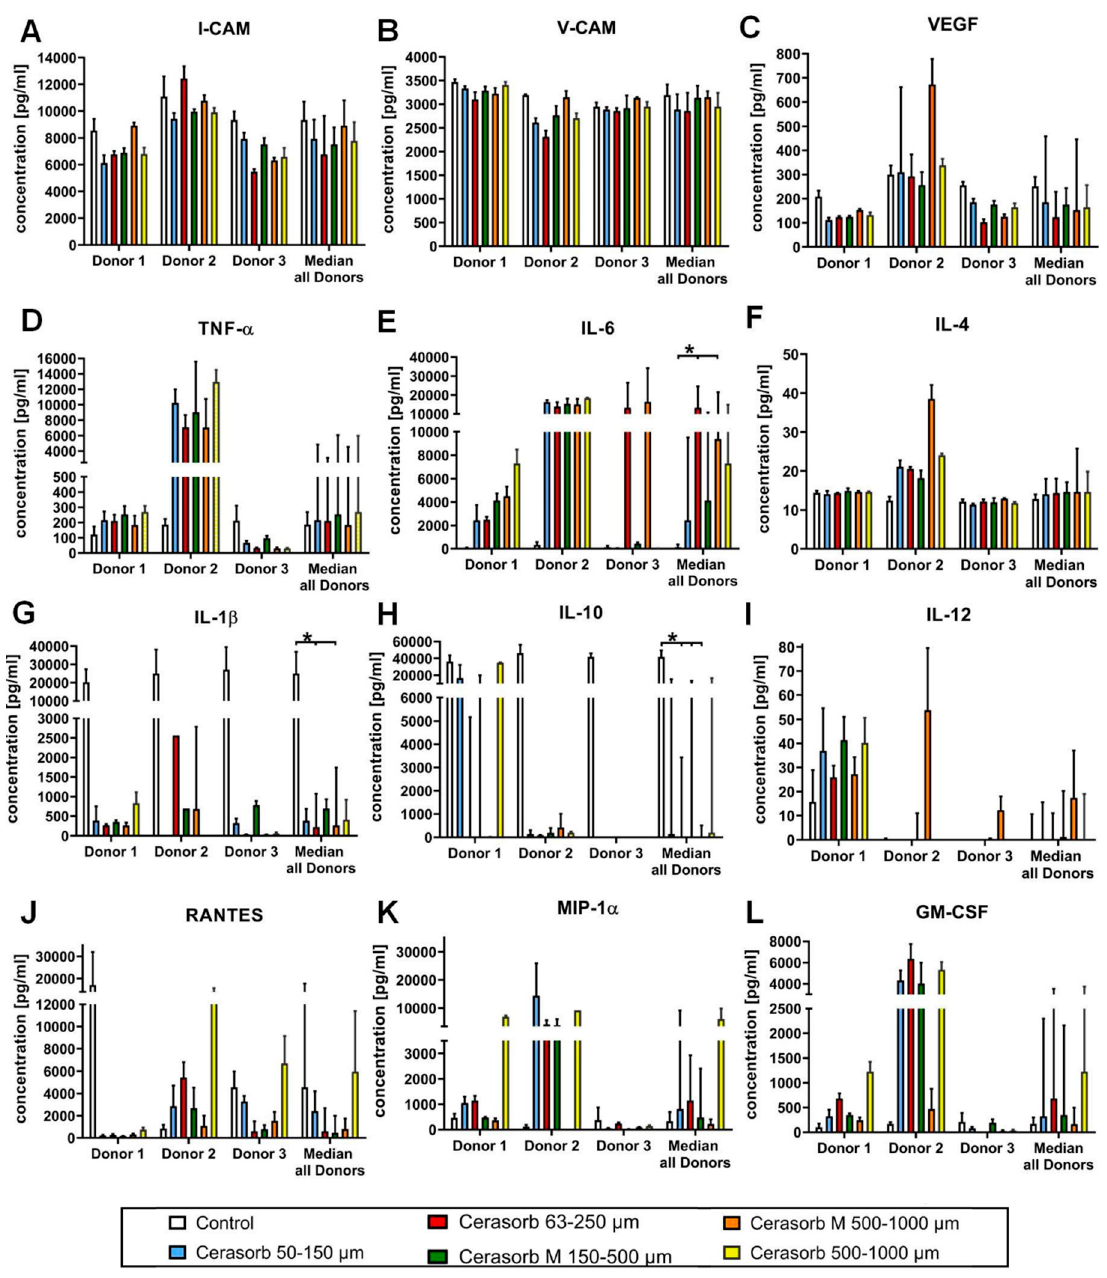
Figure 5. Cytokine concentrations after monocyte cell growth. The graphs display the median concentrations of analyzed cytokines ( A ) I-CAM, ( B ) V-CAM, ( C ) VEGF, ( D ), TNF- α , ( E ) IL-6, ( F ) IL-4, ( G ) IL-1 β , ( H ) IL-10, ( I ) IL-12, ( J ) RANTES, ( K ) MIP-1 α and ( L ) GM-CSF in the individual donors and the overall median of all donors. Data are shown as medians ± SD. Significant differences are marked with a star.